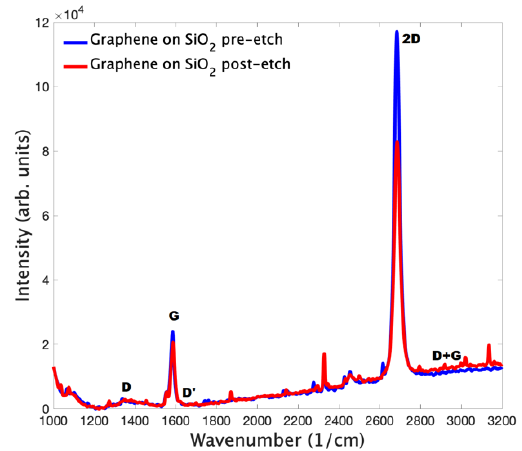
Figure 3. Raman spectra of graphene on SiO 2 before O 2 plasma etch and after. The identifying peaks G (1580 cm −1 ) and 2D (2690 cm −1 ) are present. The disorder peaks D (1350 cm −1 ), D’ (1620 cm −1 ), and D+G (2940 cm −1 ) are minimal.